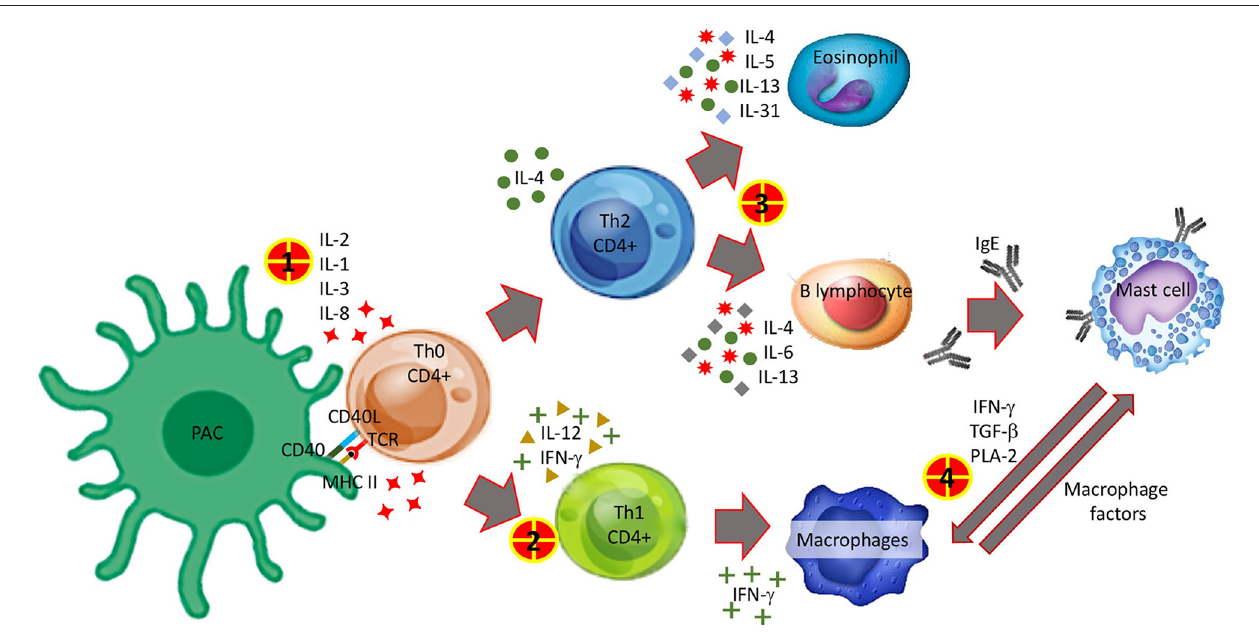
FIGURE 1 | Possible mechanisms involved in the appearance of the converter phenotype. 1 Interleukins released after antigen presentation and lymphocyte differentiation to CD4 + Th1 and Th2 may be related to the occurrence of non-immediate reactions. 2 Th1 polarization. 3 Th2 polarization. 4 The pathway by which macrophages and monocytes are activated in cytokine release reactions is not entirely clear. On the one hand, it could be a non-predominant activation of Th1 that would allow these cells to discharge a large amount of cytokines responsible for the symptoms and, on the other hand, mast cells would establish a bridge with these and other cells of the innate immune system by releasing more cytokines that would amplify the immune response and contribute to